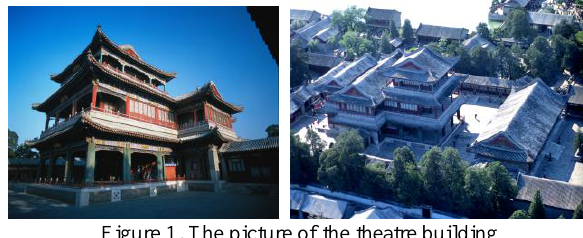
Figure 1. The picture of the theatre